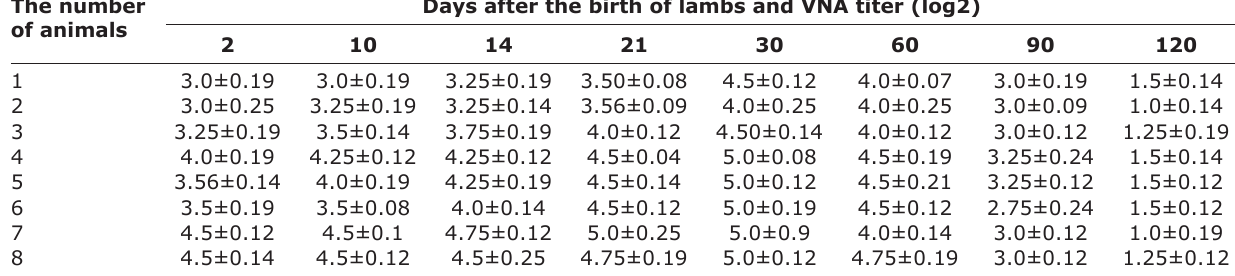
Table-3: Dynamics of the formation of colostral immunity in lambs. The number of animals